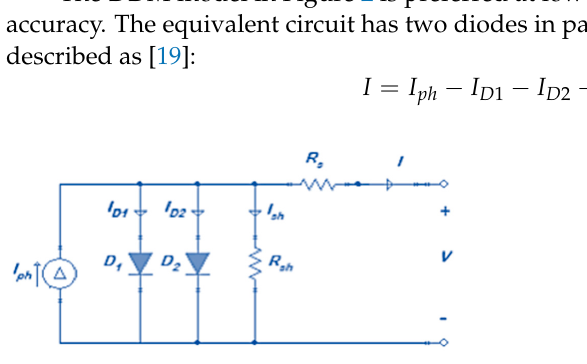
Figure 2. Equivalent circuit of the double diode model